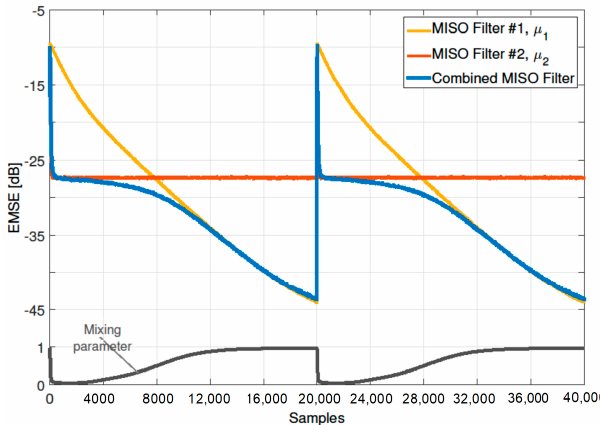
Figure 3. Convergence performance of a combined MISO filter using different step-size values with the related evolution of the mixing parameter λ 0 [ n ] .